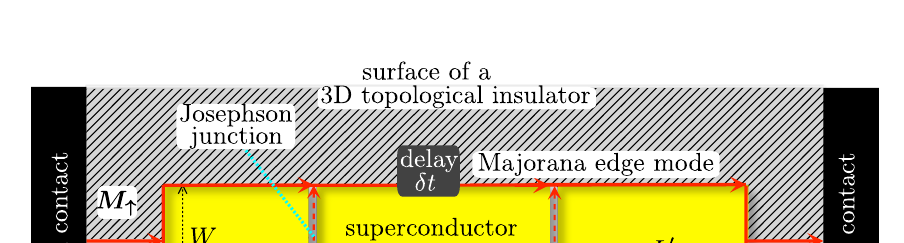
( t ) that A , B ( t ) across the A , B